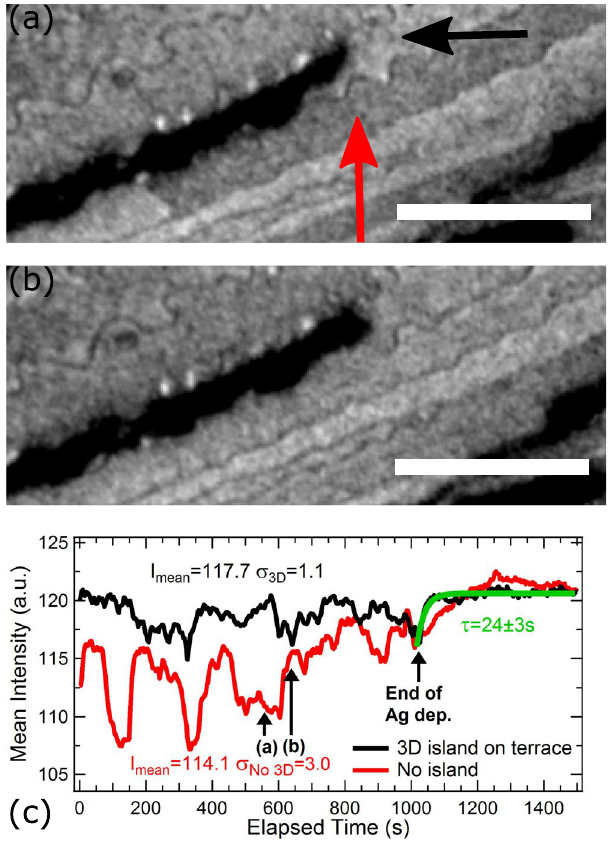
Figure 5. ( a,b ) Snapshots [from Fig. 1(a)] of the growth of a 3D island (black intensity) before ( a ) and after ( b ) it crosses the delimiting step with the terrace marked by the red arrow. Between ( a ) and ( b ), the adatom concentration of the terrace marked by the red arrow has decreased toward its stationary value ( .  c 0 04 ML ). The scale bar is 1.5 μ m and ε = 24 eV. ( c ) Intensity time-evolution of the atomic terraces stat indicated in ( a ) by red and black arrows. The timeline of the snapshots ( a ) and ( b ) is